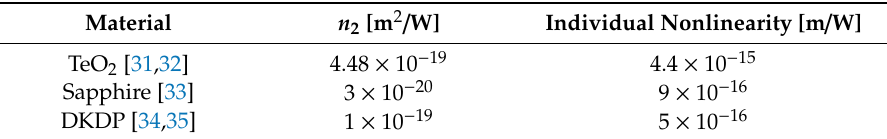
Table 1. Comparison of individual